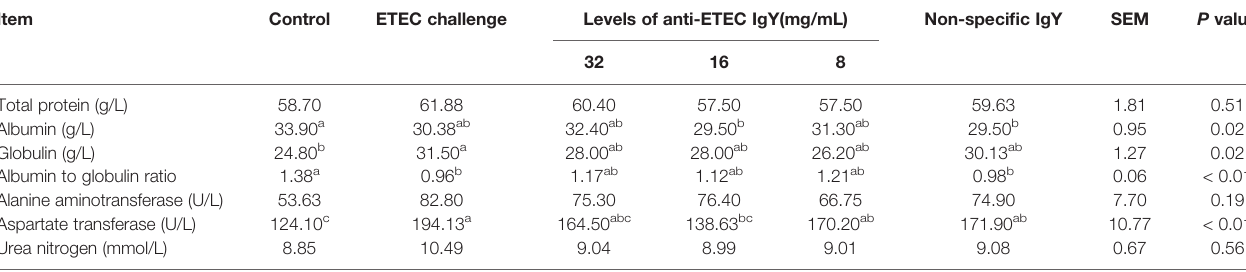
TABLE 1 | Effects of IgY on serum biochemical parameters of mice challenged by ETEC K88. Item